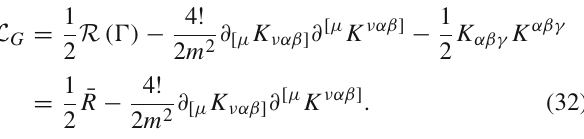
This action is equivalent to the cosmological constant action, but is invariant under the gauge symmetry (13).